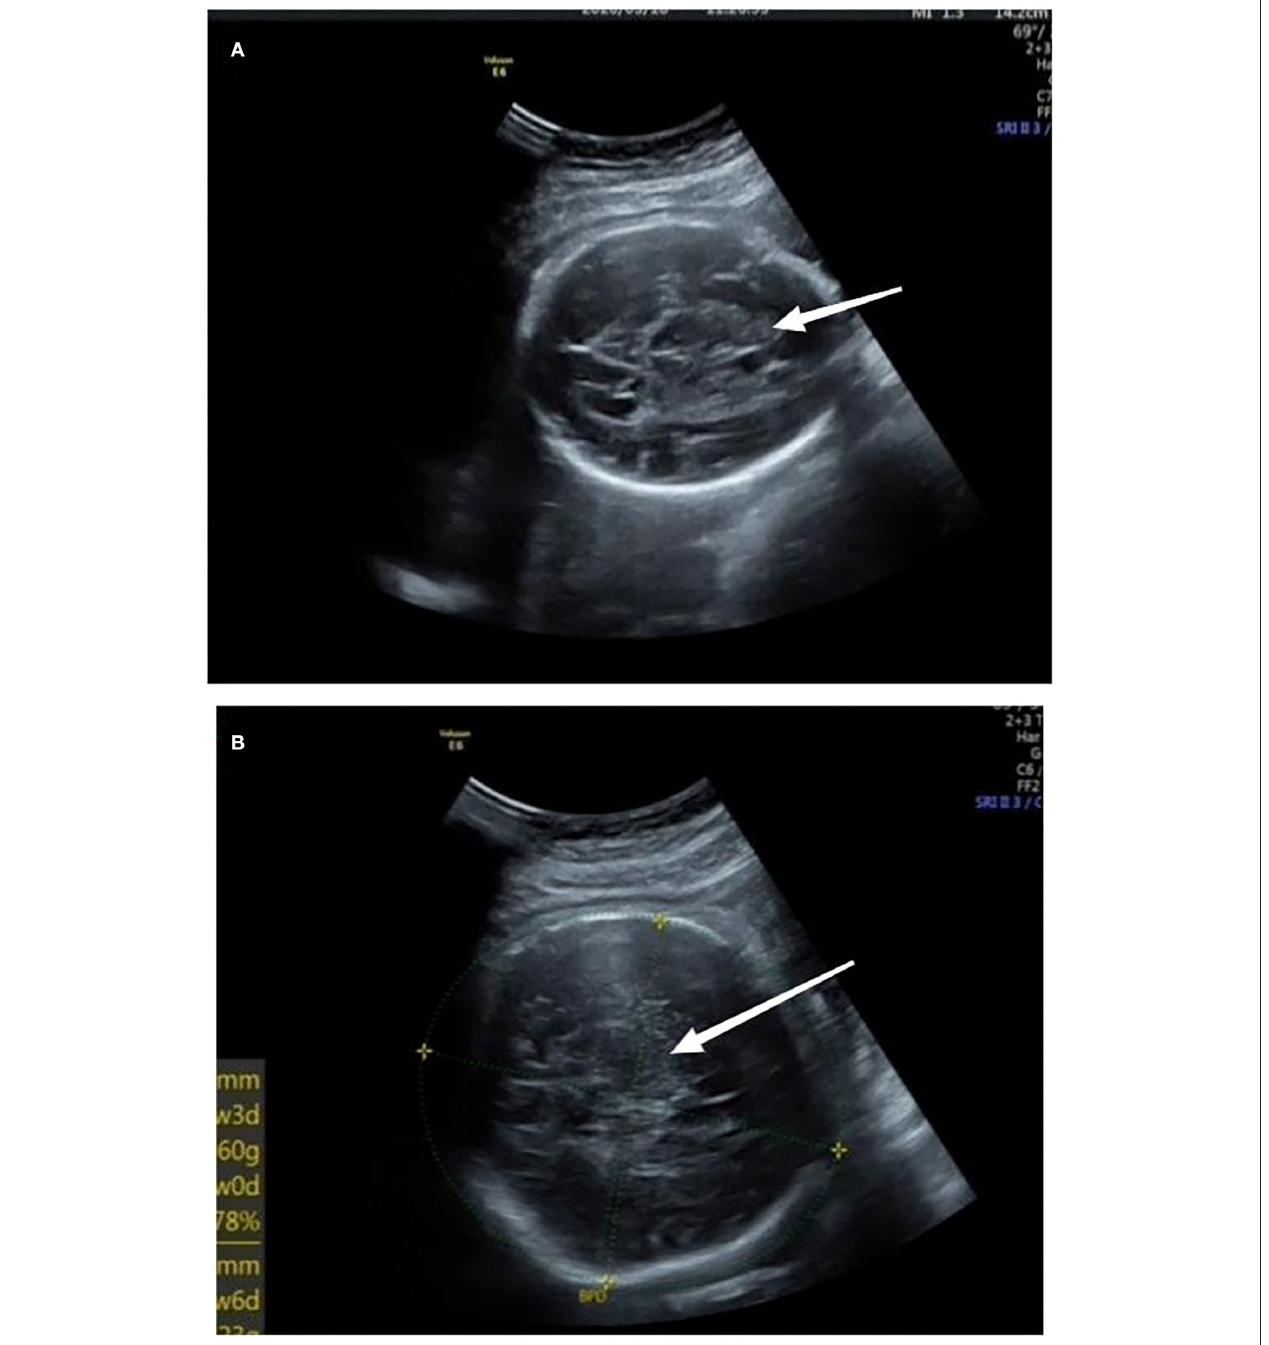
FIGURE 1 | (A) At 30-weeks’ gestation, there was a medium to high echoic mass in the parenchyma of the right lobe of liver with a size of 1.8cm × 1.8cm × 1.5cm and a clear boundary surrounded by a low echoic dark halo; inside of the mass, a few strips of blood flow signals could be detected. (B) At 38-weeks’ gestation, a mass located in the right lobe of the liver, which had increased to a size of 7.1cm × 7.9cm × 5.6cm. Arrows referred to uneven echoes.